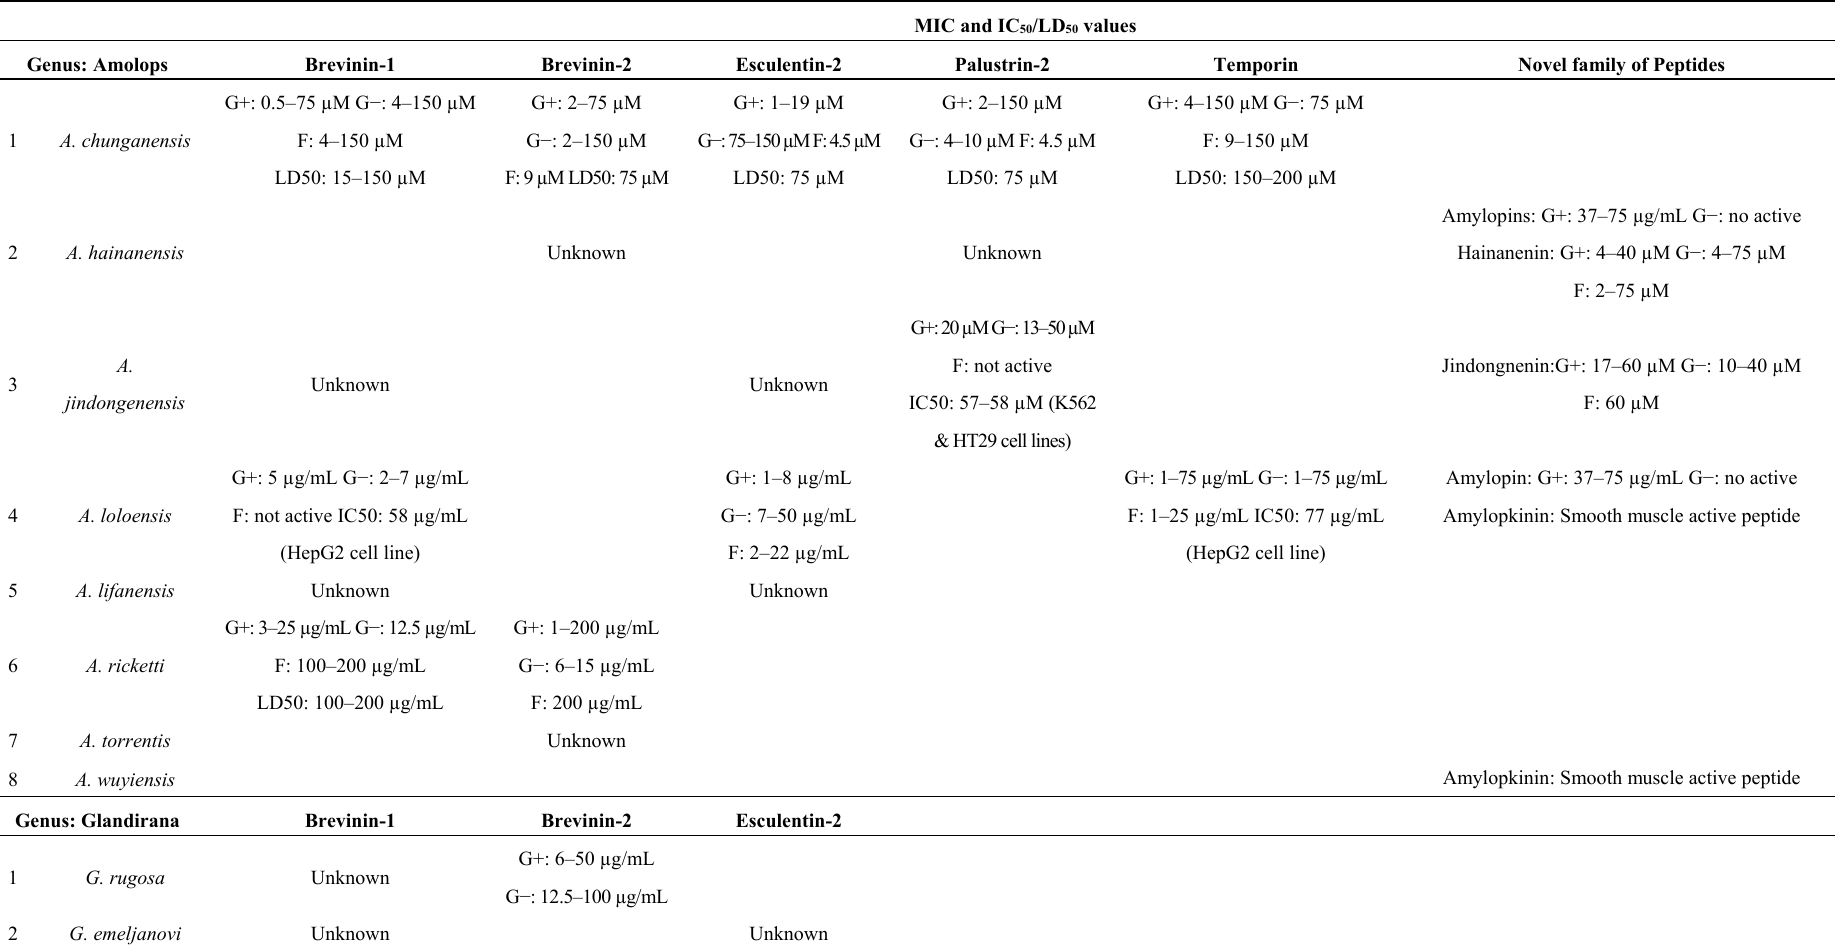
Table 2. List of peptides identified from the skin secretion of Asian frogs with their corresponding MIC and IC 50 /LD 50 values. MIC and IC 50 /LD 50